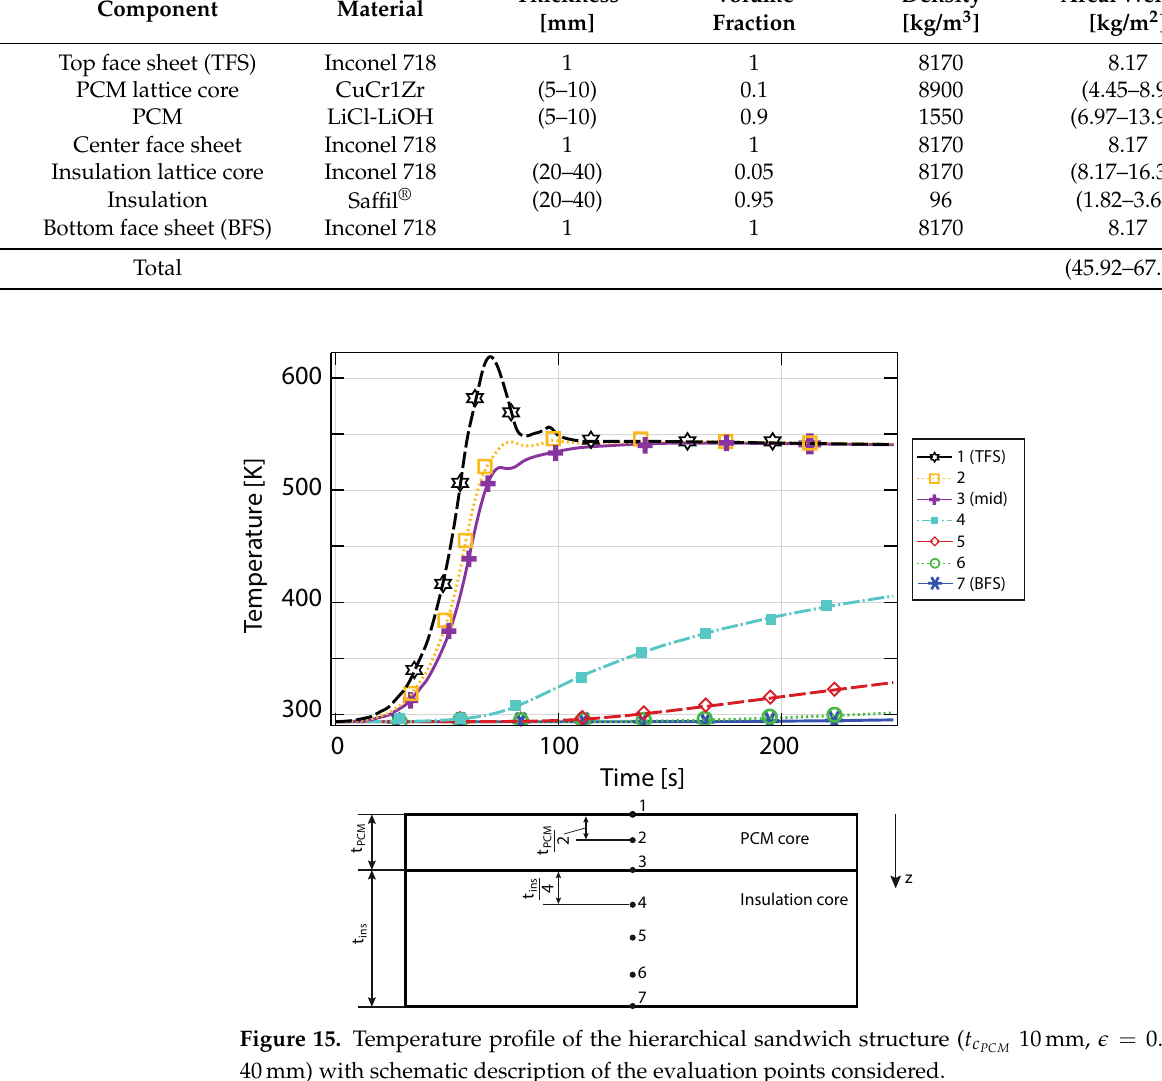
Figure 15. Temperature profile of the hierarchical sandwich structure ( t c 40mm) with schematic description of the evaluation points